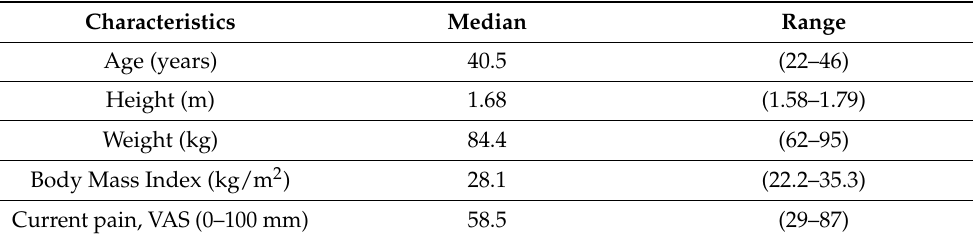
Table 2. Descriptive information of study